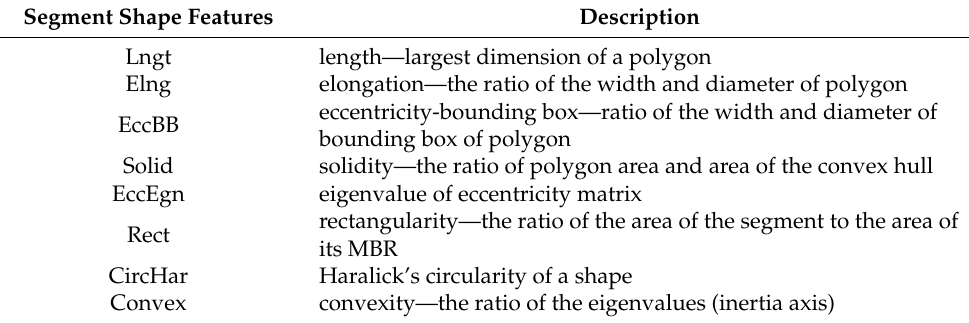
Table 2. Overview of the segment shape